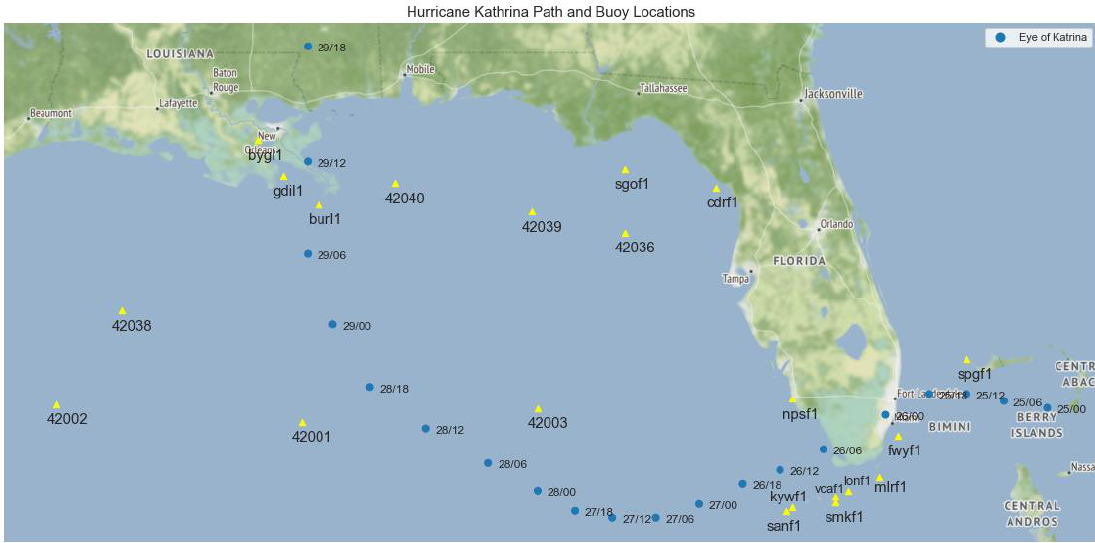
Figure 7. Buoy locations and path of Hurricane Katrina.